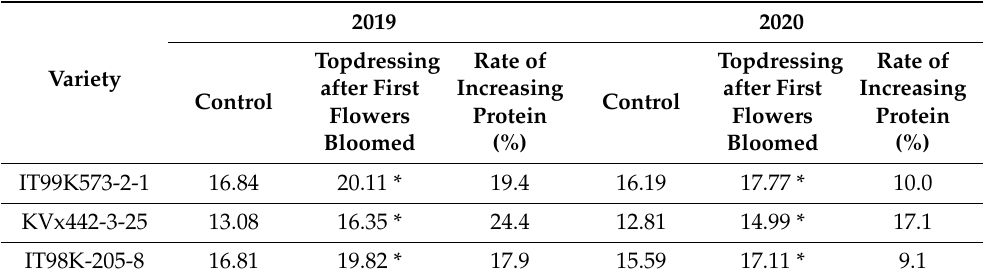
Table 5. Effects of topdressing (additional fertilizer) treatment at flowering period for protein content (%) in cowpea seeds. 2019 2020 Rate of Topdressing Rate of Topdressing Variety Increasing after First Increasing after First Control Control Protein Flowers Protein Flowers (%) Bloomed (%) Bloomed IT99K573-2-1 16.84 20.11 * 19.4 16.19 17.77 * 10.0 KVx442-3-25 13.08 16.35 * 24.4 12.81 14.99 * 17.1 IT98K-205-8 16.81 19.82 * 17.9 15.59 17.11 *